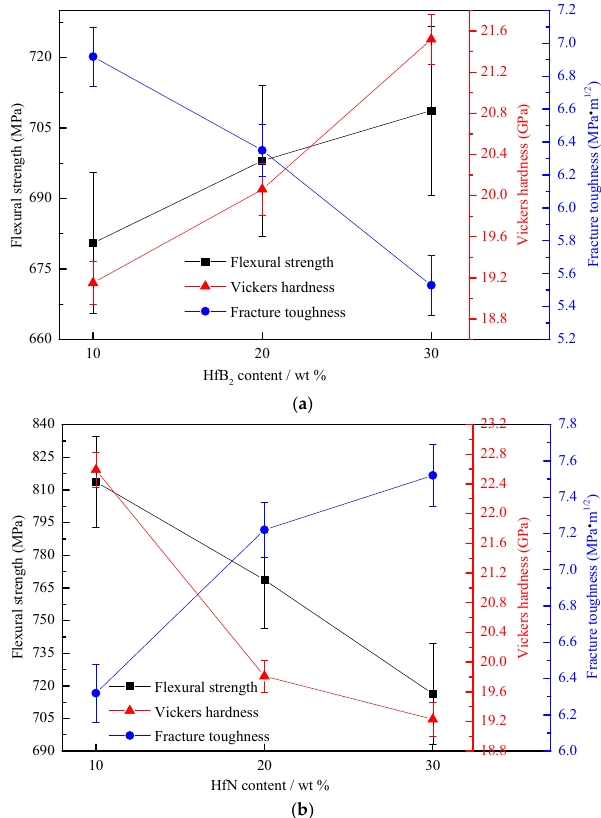
Figure 6. Variation of the mechanical properties of TiB 2 -HfB 2 ceramics with a change of the HfB 2 content and variation of the mechanical properties of TiB 2 -HfN ceramics with a change of the HfN content.